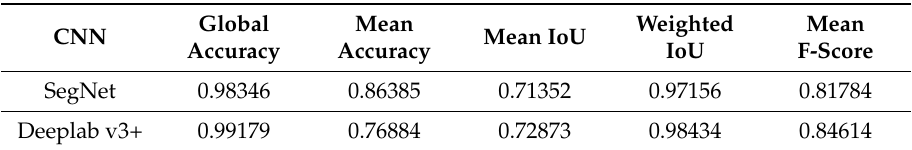
Table 5. Dataset Metrics.